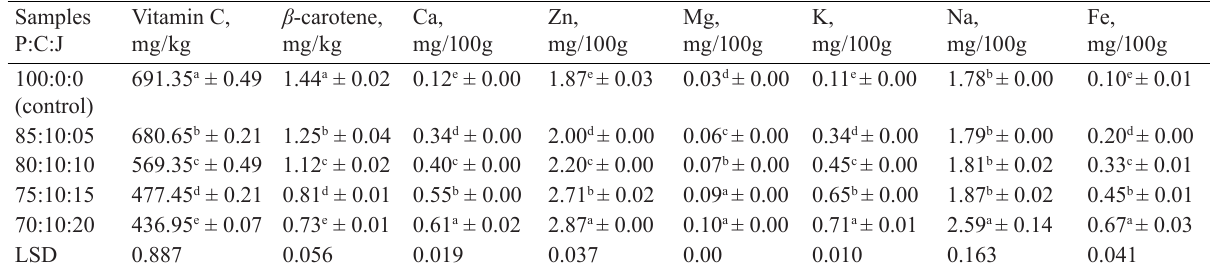
Table 2 Vitamin and mineral content of jam from cucumber, pineapple, and Jatropha leaf in different proportions Samples